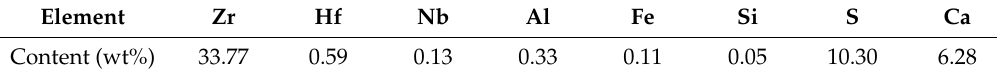
Table 5. Chemical composition of the basic zirconium sulfate precipitate.